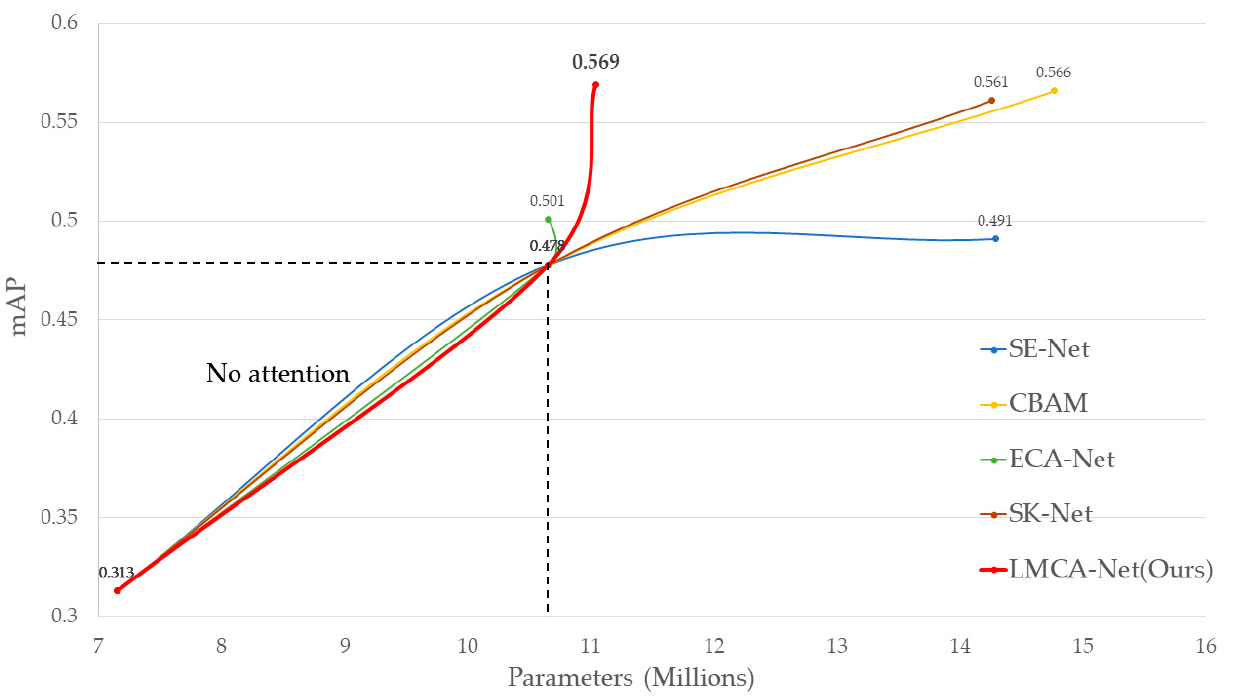
Figure 10. Performance on the baseline after adding each attention module. As can be seen from the heat map shown in Figure 11, all methods achieve good attentional results due to the large size of the Crosswalk and white line blur objects. For longitudinal linear crack detection, our proposed LMCA-Net is slightly inferior to CBAM. For small object detection like bumps and potholes, LMCA-Net can ultimately achieve the same attention effect as CBAM and SK-Net. For the case of multiple objects combined, our method accurately generates more highlighted regions for multi-scale objects. It can achieve the same attention effect as the larger model with a smaller number of parameters. Finally, we compared the road damage detection algorithm proposed in this paper with the widely used object detection algorithms SSD [39], Faster-RCNN [40], YOLO series [41–43], and EfficientDet [44]. The quantitative experimental results using the same dataset and model training methods are shown in Table